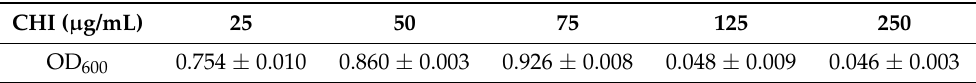
Table A1. Minimum inhibitory concentration (MIC) of the free